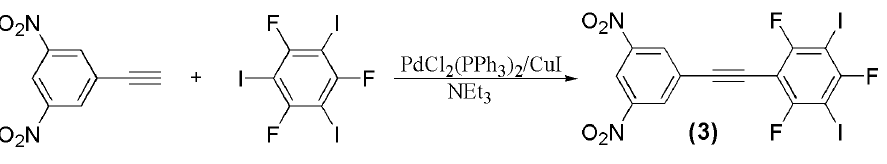
Figure 3. Synthesis of diiodotolane ( 3 ).